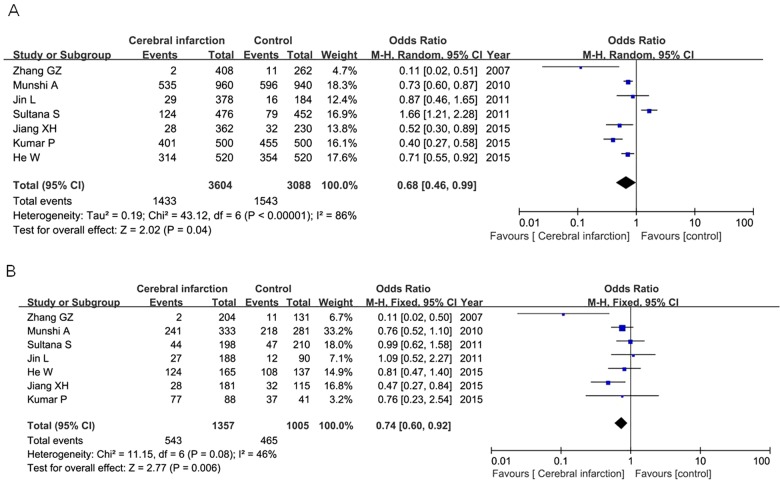
Forest plot of the association between IL-10 −1082A/G polymorphism and cerebral infarction risk under the allelic model (A) and heterologous model (B).